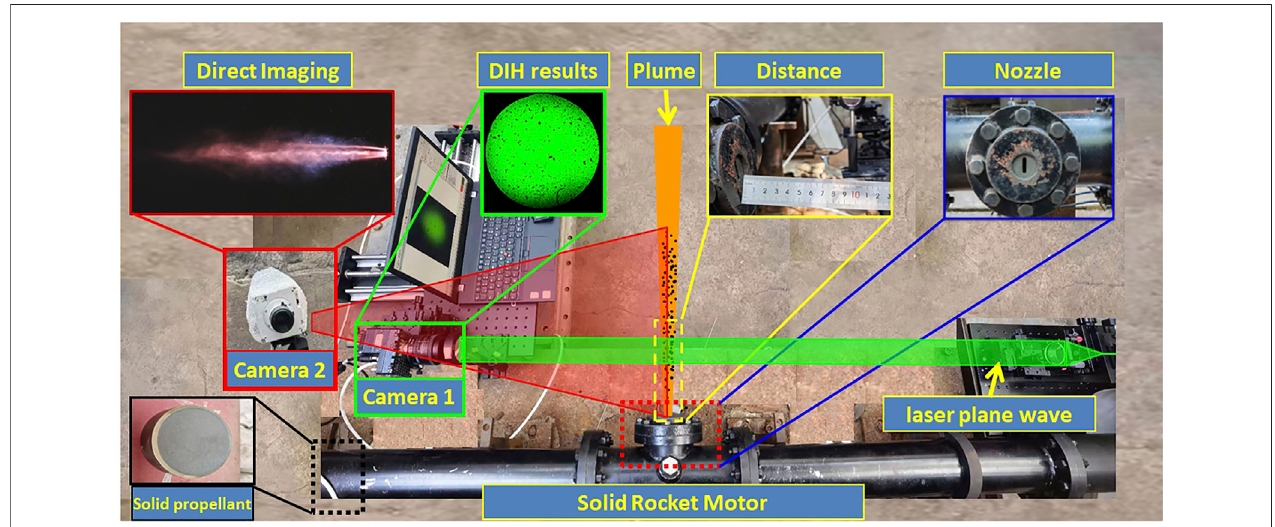
FIGURE 1 | Experimental system for DIH measurement of solid rocket plume fl ow fi